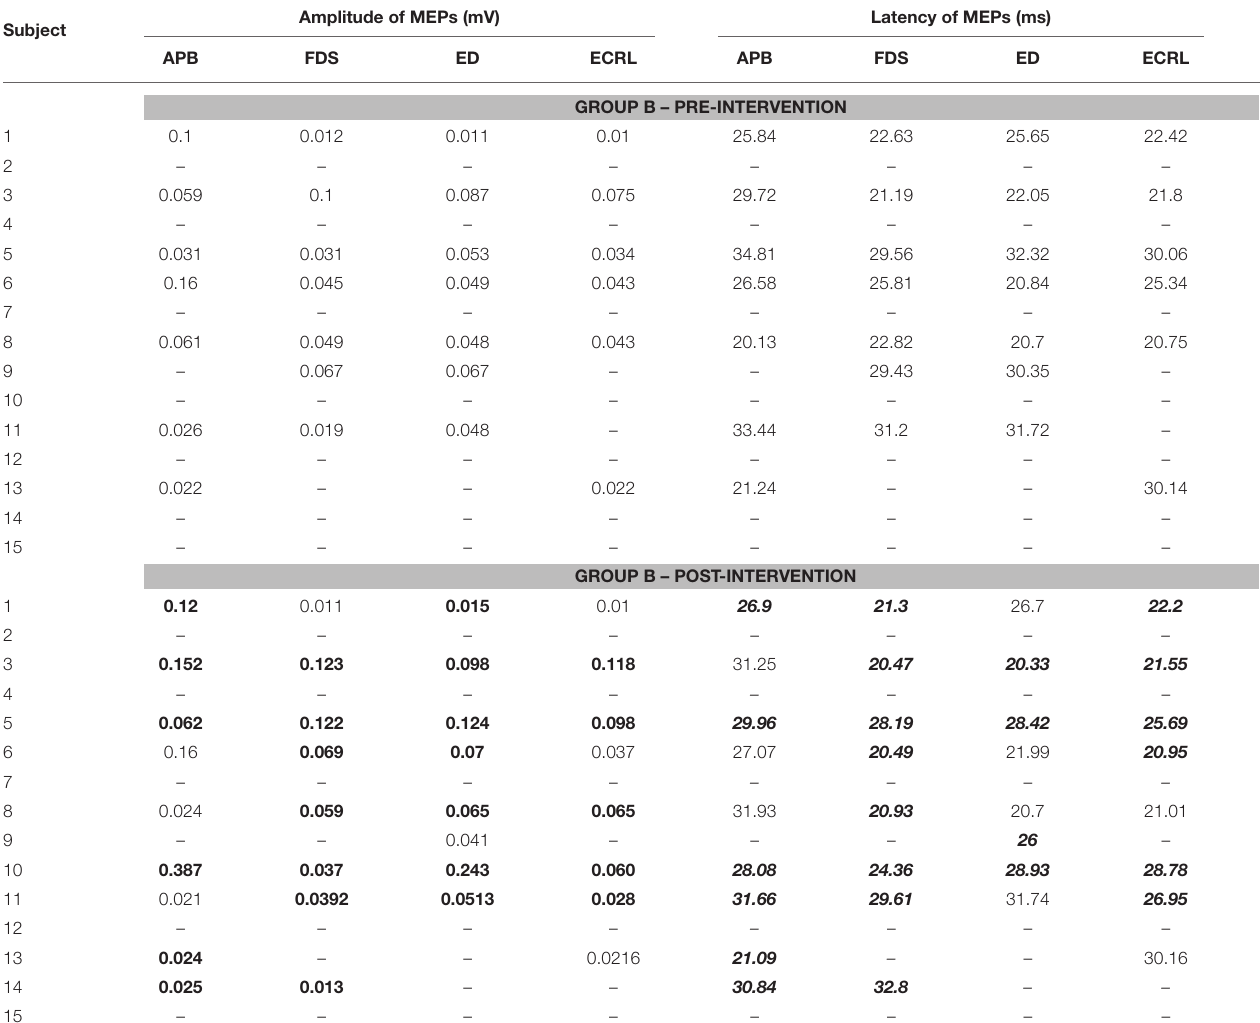
TABLE 4 | Results of Motor evoked potentials (MEPs) on the affected side in Group